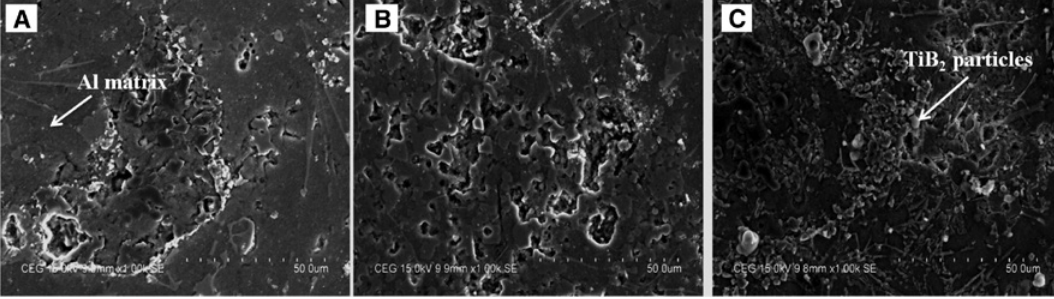
composite fabricated at 30 min AT and HTs of (A) 20 min, (B) 30 min, and (C) 40 Figure 4: Microstructures of the Al/TiB 2